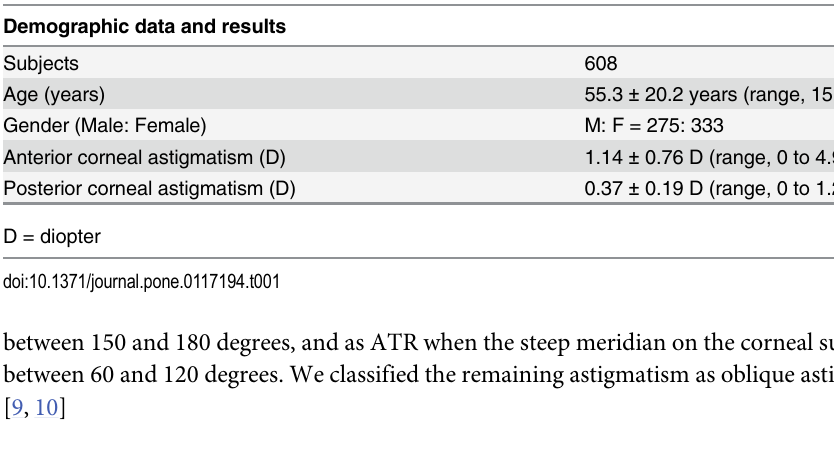
Table 1. Demographics of the study